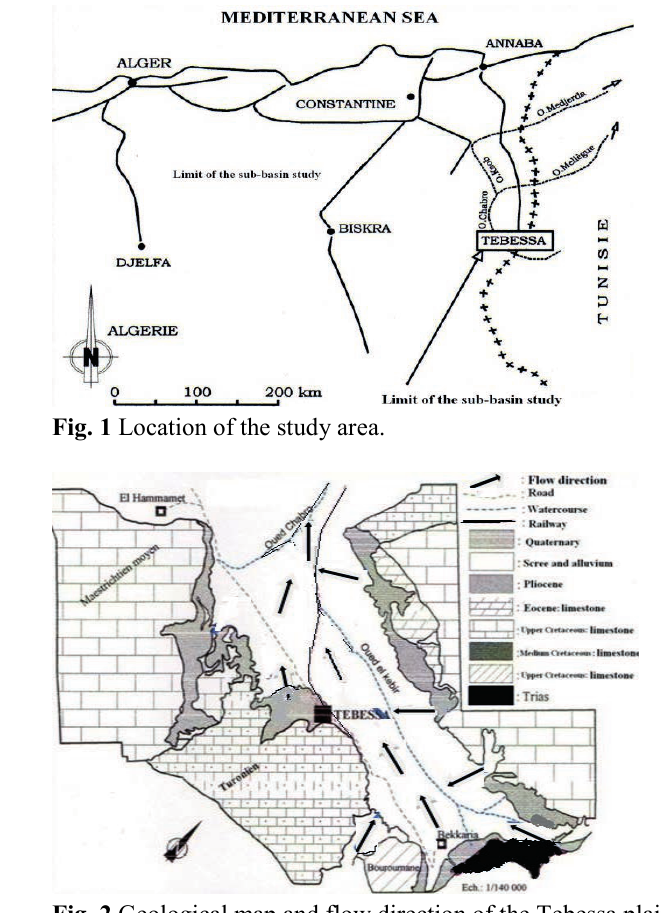
Fig. 2 Geological map and flow direction of the Tebessa plain (Djabri